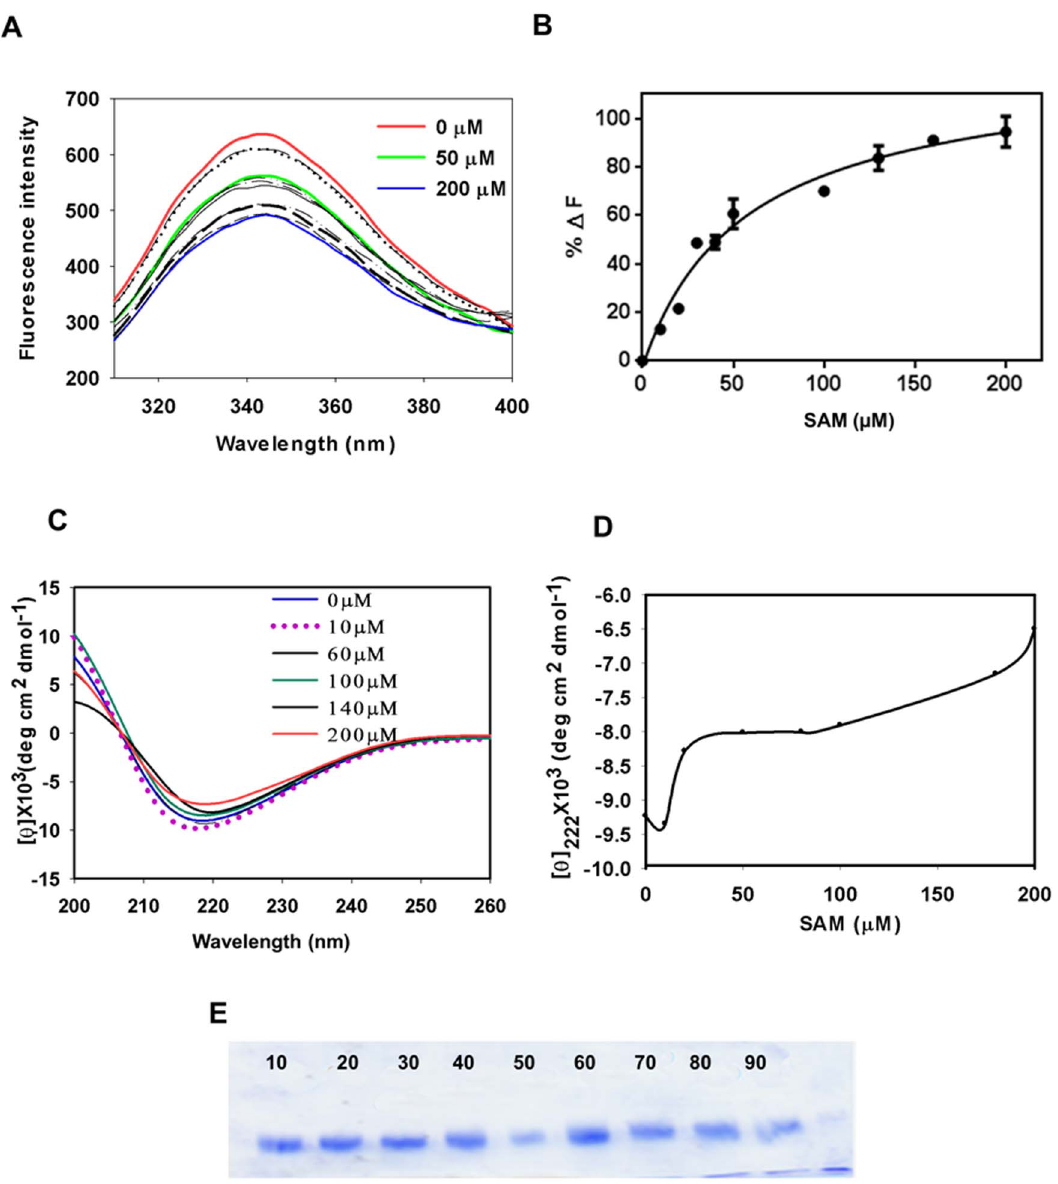
Figure 5. SAM binding analysis by fluorescence and far-UV CD spectroscopy. (A) Graph shows effect of increasing concentration of SAM causes quenching of tryptophan fluorescence (B) Saturation binding isotherm with dissociation constant 51 m M shows L. donovani ADL binds to SAM. (C) Far-UV CD spectra shows change in secondary structure with increasing concentration of SAM. (D) Change in secondary structure, with increasing concentration of SAM (0–200 m M) was monitored by molar ellipticity value at h 222 , shows increasing concentration of SAM brings conformational change in protein. (E) Trypsin assisted limited proteolysis in presence of increasing concentration of SAM (10–80 m M) shows SAM binding does not affects folding